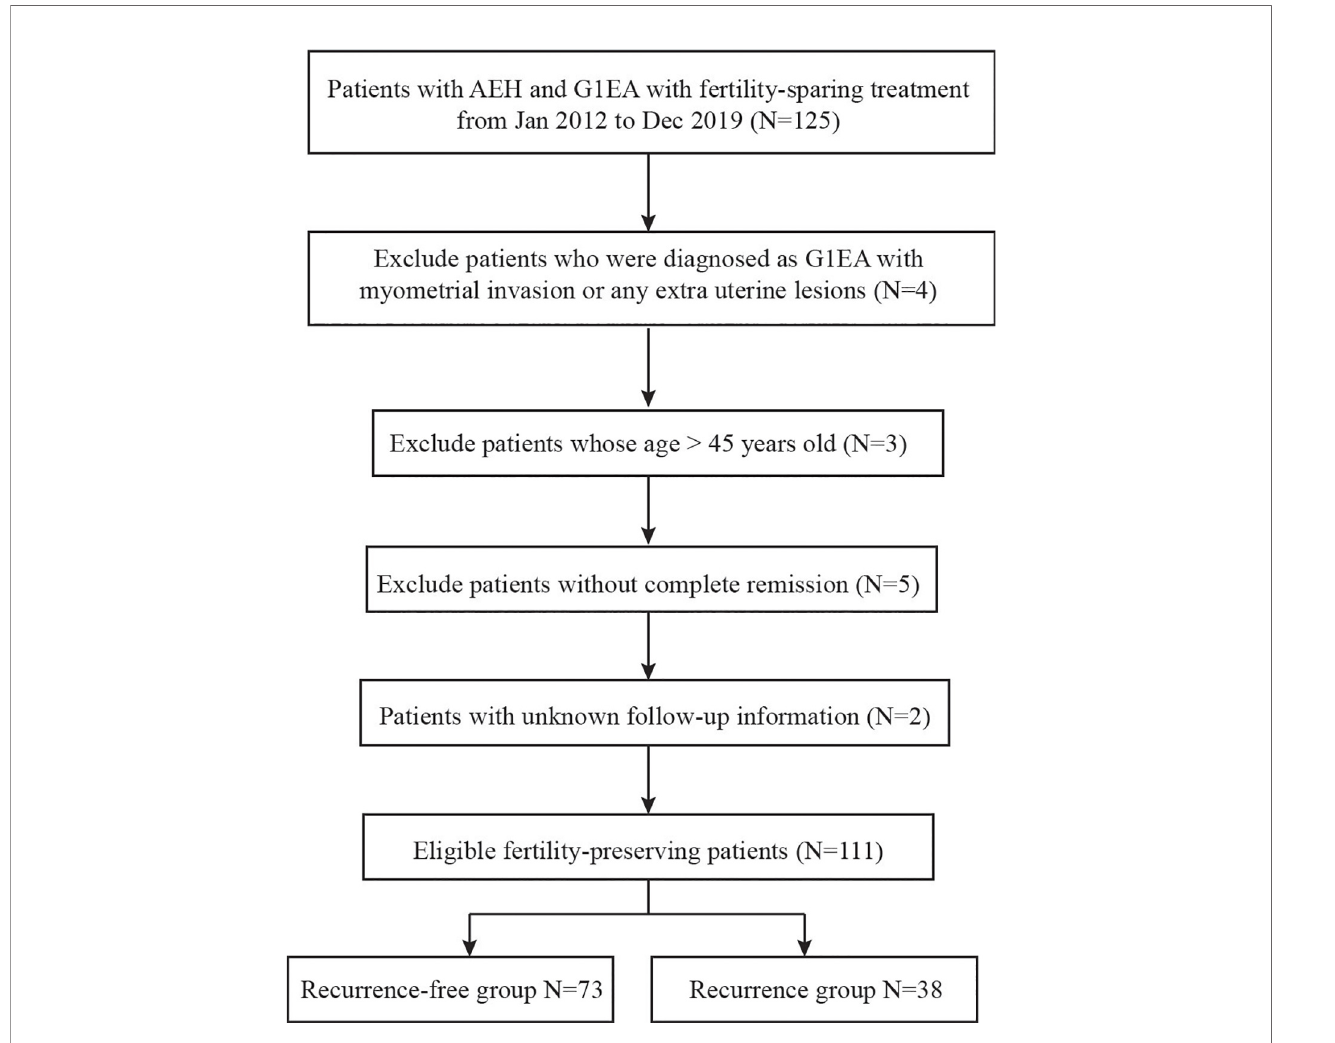
FIGURE 1 | Flow diagram of inclusion criteria and exclusion